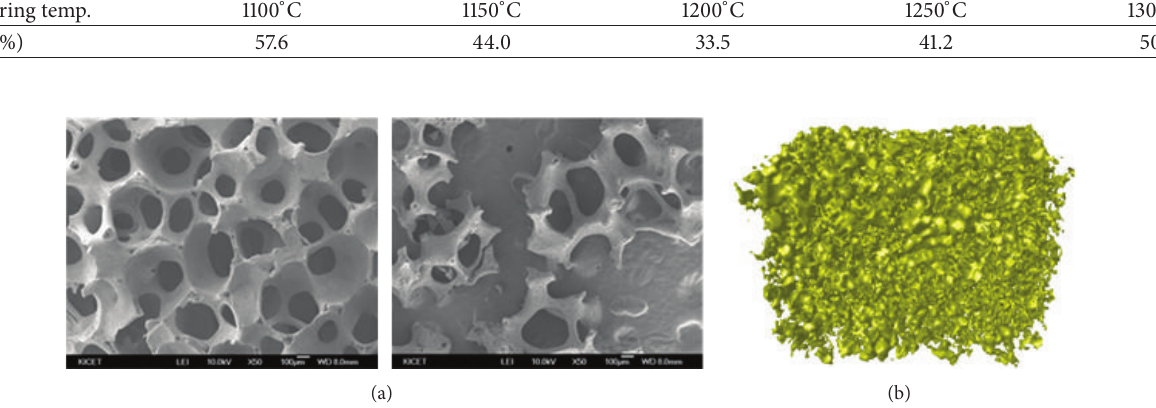
Figure 4: Micro-structure of 60TCP40HA. (a) SEM images of porous (left) substrate and (right) granules manufactured by sponge method. (b) Micro-CT image of packed granules which are in the range of 0.6 mm and 1.0mm.